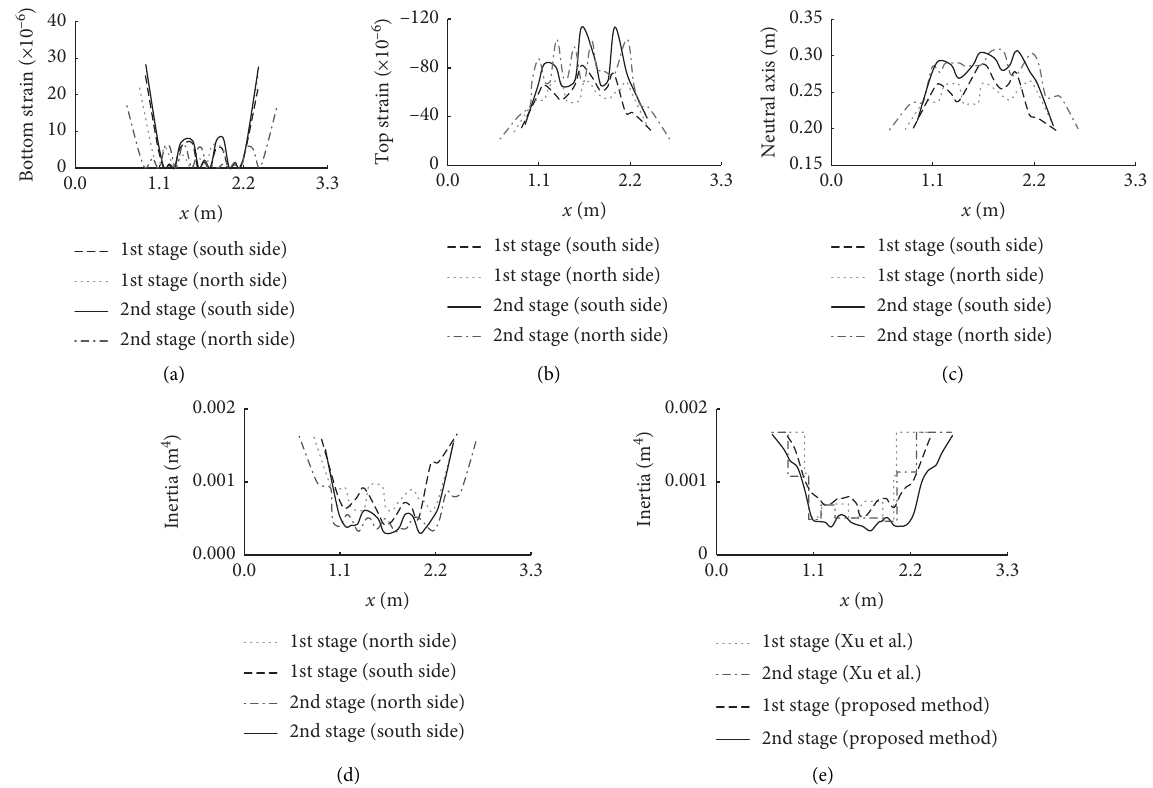
Figure 6: Calculated results of the key sections in the beam B1 (the load P � 9 . 09 kN): (a) bottom strains; (b) top strains; (c) neutral axes; (d) inertias for two sides; (e) average